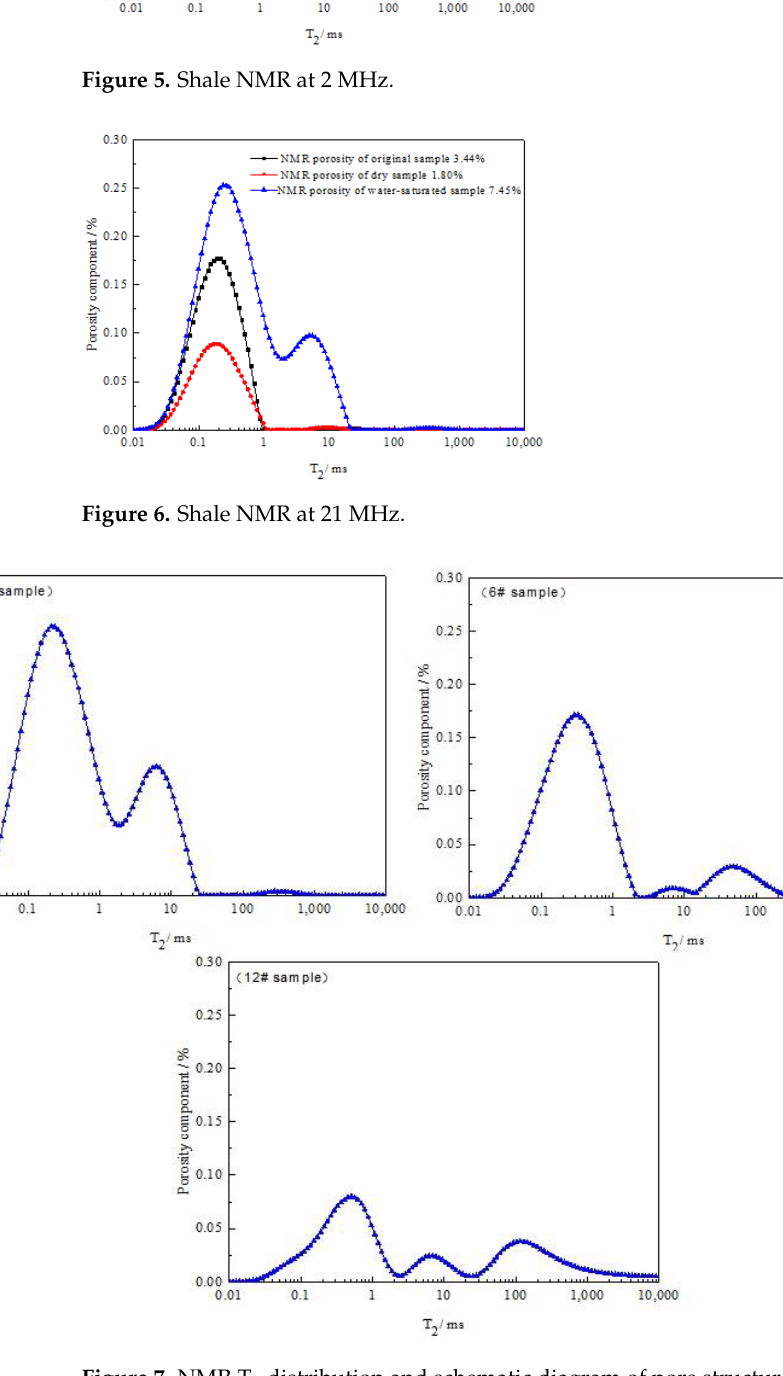
Figure 7. NMR T 2 distribution and schematic diagram of pore structure parameter calculation.